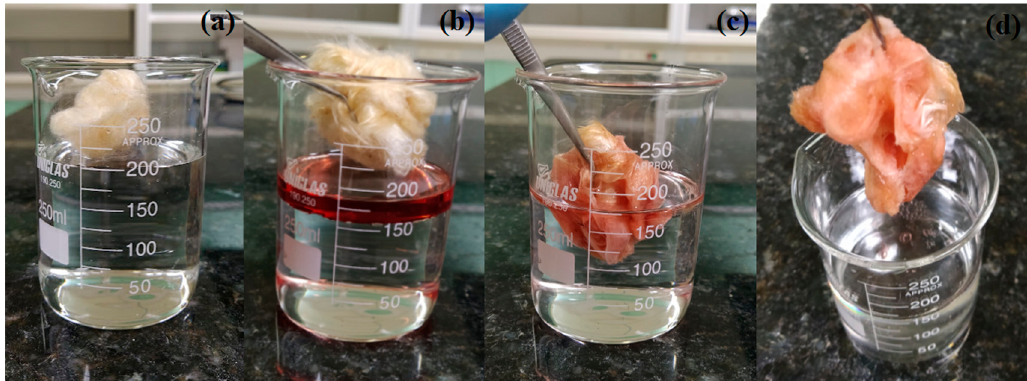
Figure 7. Digital images of the water sorption test ( a ) and removal of diesel oil in water using CPNaOHT ( b – d ), ( b ) a volume of oil was added in distilled water forming a supernatant layer, ( c ) rapid oil sorption diesel by CPNaOHT, and ( d ) clean water after diesel sorption.